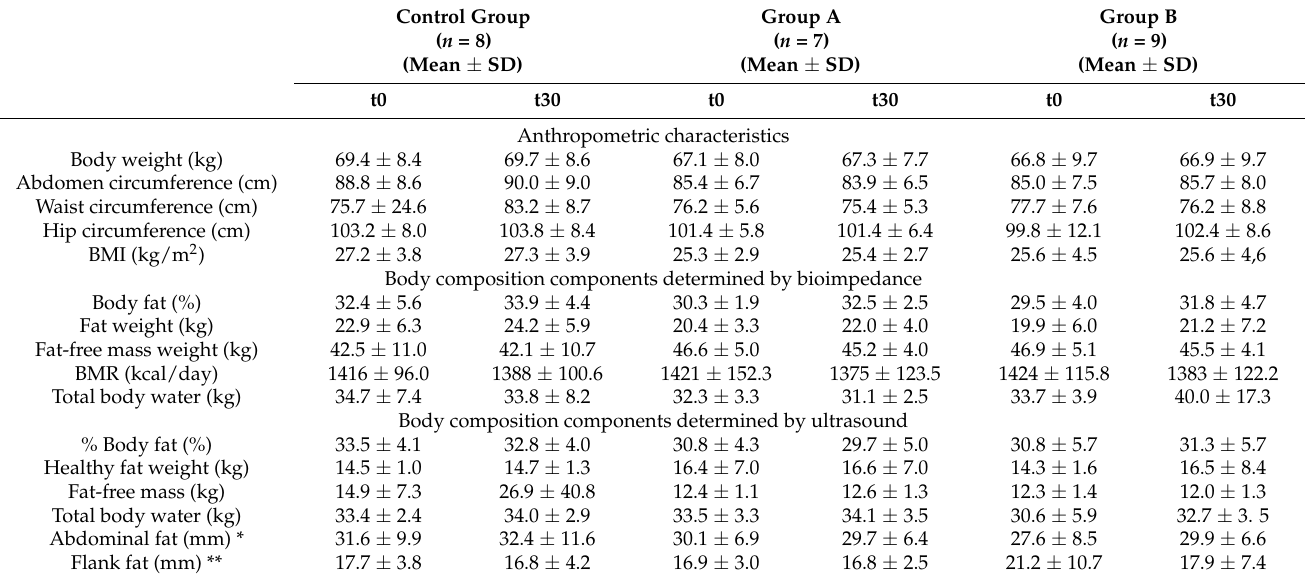
Table 1. Anthropometric and body composition characteristics of adult women subjected to cryolipol- ysis on one (group A) or multiple areas of the body (group B).